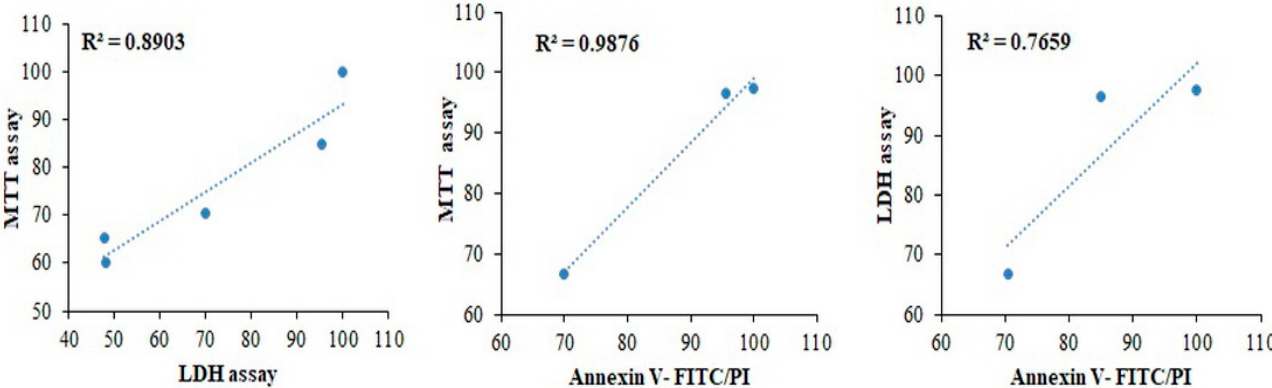
Figure 8. Correlation of 3-(4,5-dimethylthiazol-2-yl)-2,5-diphenyl tetrazolium bromide (MTT) assay, lactate dehydrogenase (LDH) assay and Annexin V-fluorescein isothiocyanate (FITC)/propidium iodide (PI) staining of drug treatment on polydimethylsiloxane (PDMS) multi-channel cell chip cultured HeLa cells.